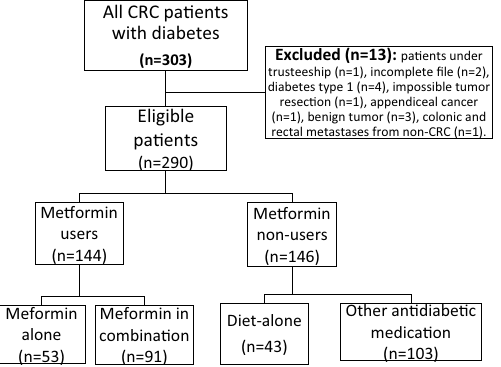
Figure 1. Flowchart showing the process of enrollment of colorectal cancer patients.